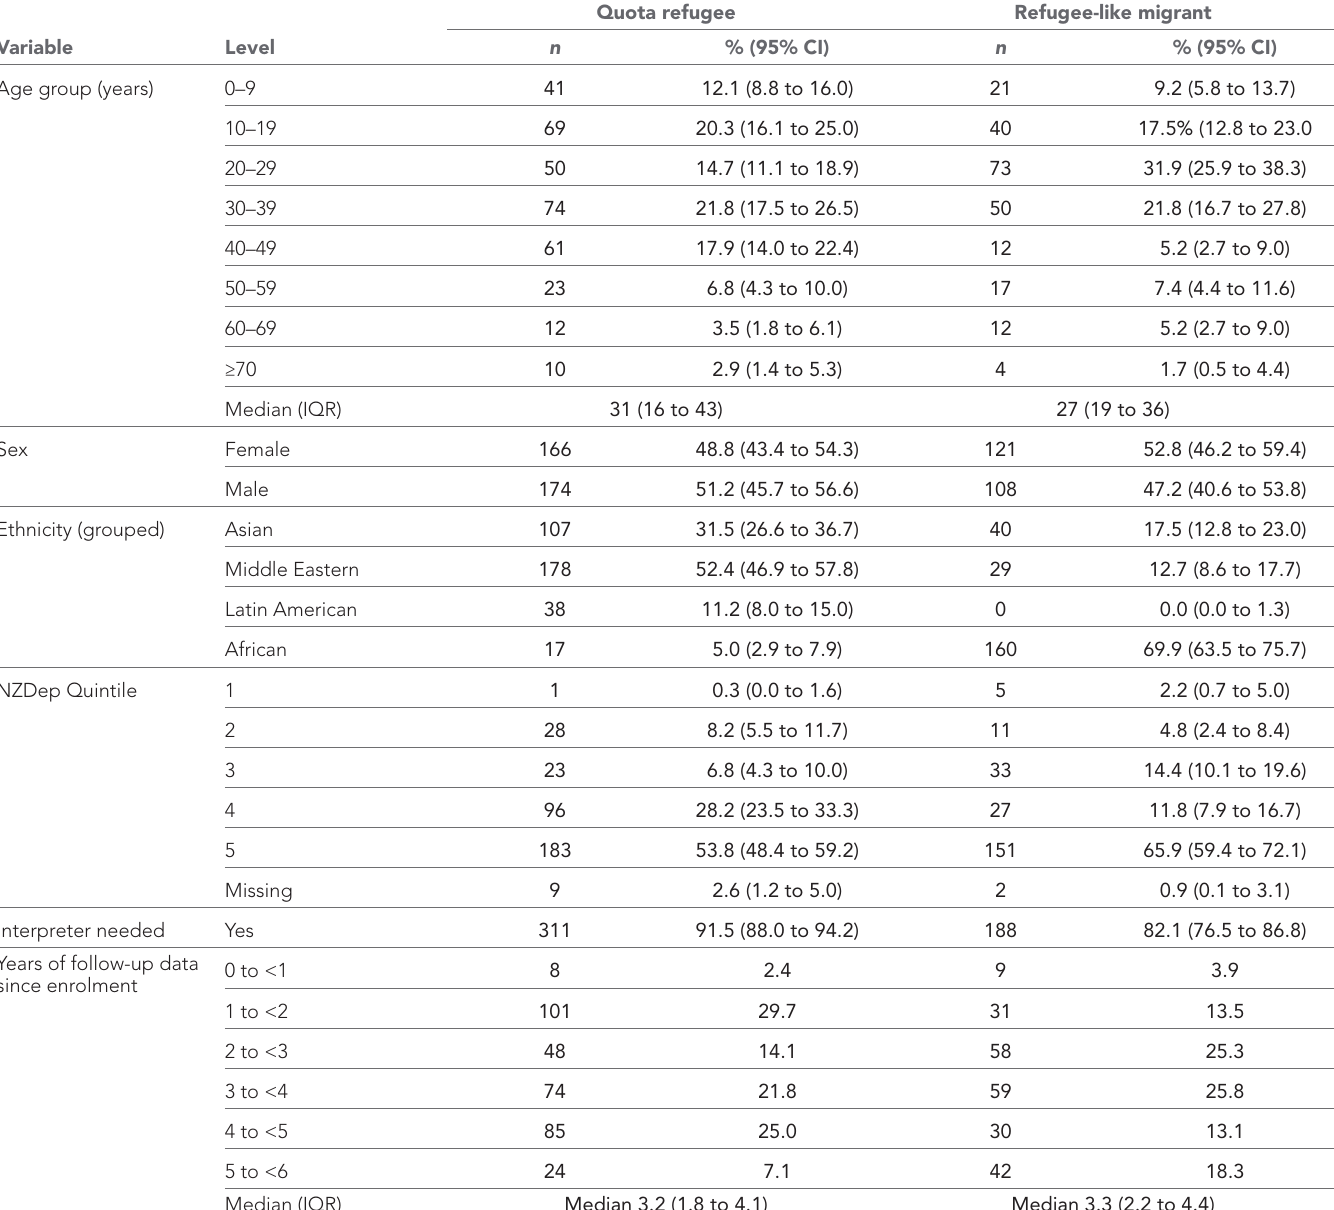
Table 2 Sociodemographic characteristics of refugee- like migrants ( n = 229) and quota refugees ( n = 340) at enrolment in practice